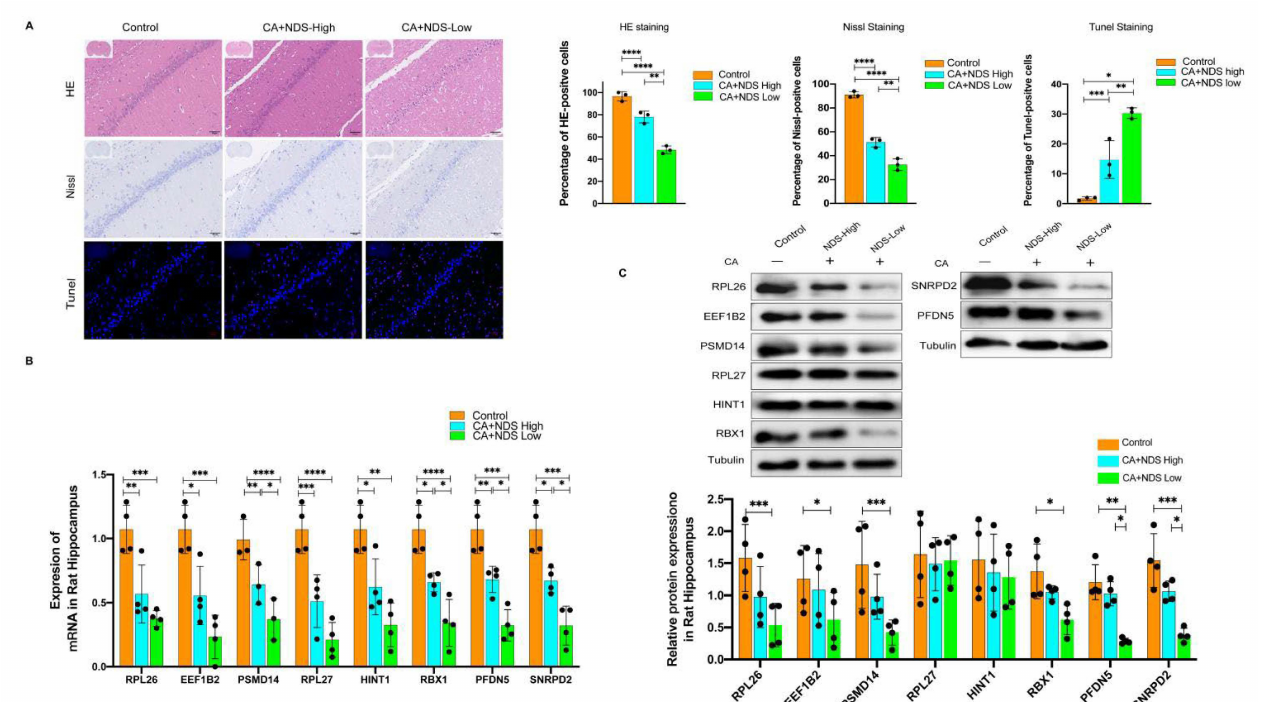
Figure 7. Validation of the hub genes. ( A ) Representative pictures of H&E staining, Nissl staining, and Tunel staining. ( B ) The mRNA expression of the 8 hub genes in the indicated groups. ( C ) Protein levels of the 8 hub genes in the indicated groups. Data are expressed as the mean ± SD.* p < 0.05, ** p < 0.01, *** p < 0.001, and **** p <